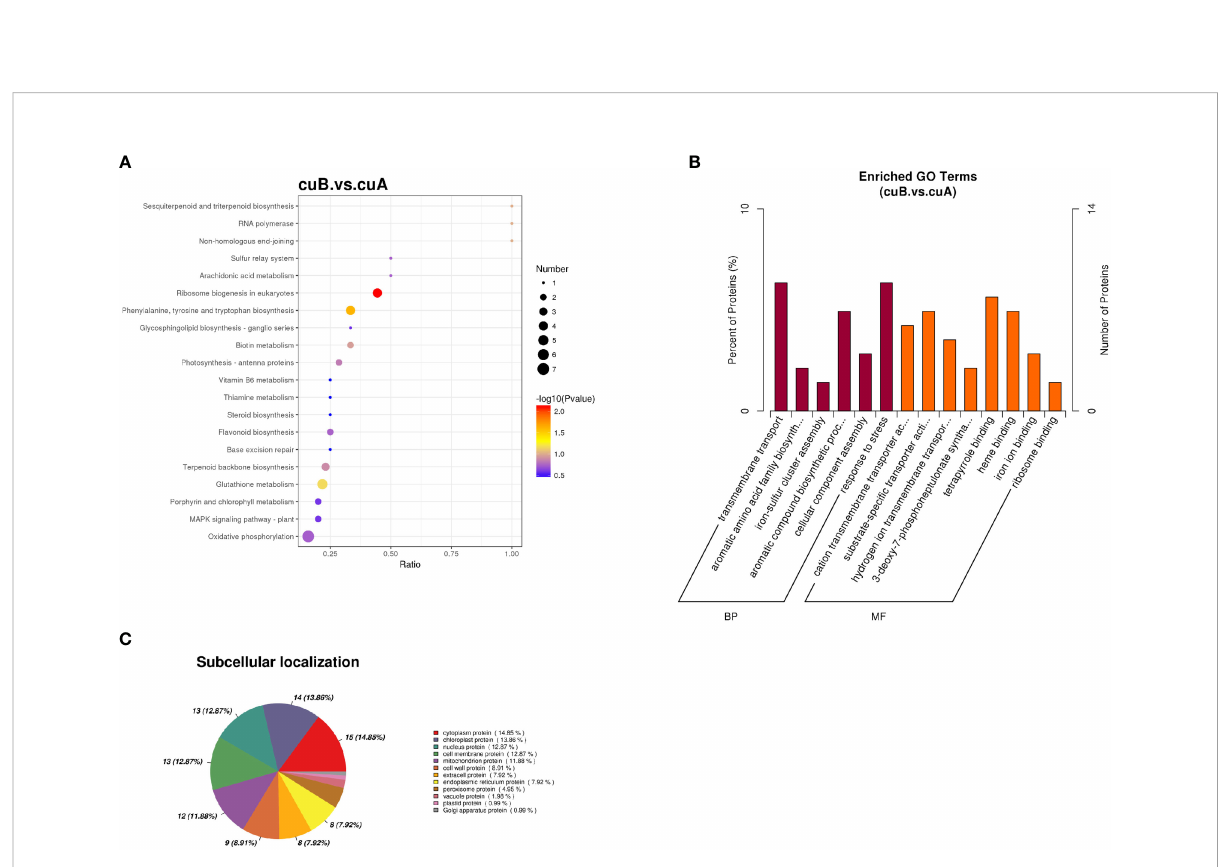
FIGURE 3 Differential expression proteins (DEPs) enrichment and localization analysis. (A) KEGG pathway of DEPs. (B) GO enrichment of DEPs. (C) Pie chart of subcellular localization of